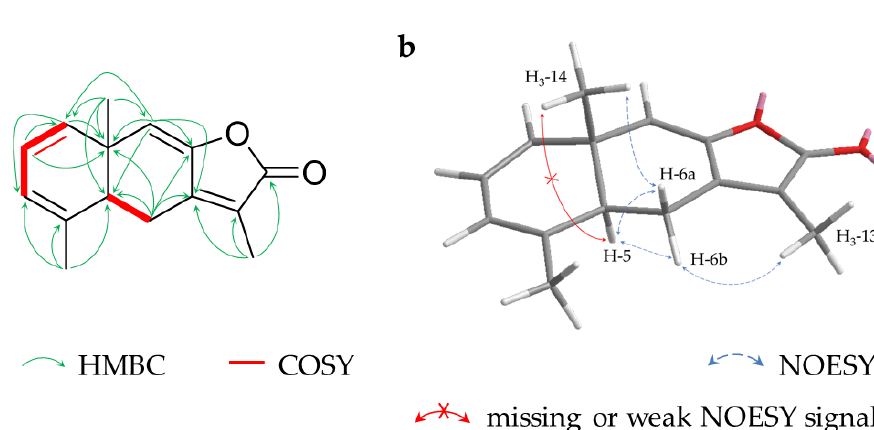
Figure 5. Key HMBC, COSY ( a ) and (missing) NOESY ( b ) correlations for compound 7 . Analysis of 2D NMR data revealed a dimer composed of a guaiane and a germacrene- type sesquiterpene, connected by a four-membered spirocycle (Figure 6a). More precisely, the spectra revealed a structure resembling commiphorine A [21]. The guaiane moiety (part I) is the C-1 epimer of the known monomer guaiane myrrhterpenoid O ( 22 ) [15] and is, thus, the same as described for the dimers commiphorine A and commiphoratone B [22]. Part (II) varies from commiphorine A. First, the double bond between C-1 (cid:48) and C-2 (cid:48) is E -configurated, deduced from NOESY signals as well as the large coupling constant of (cid:48) . Third, 3 J H-1’, H-2’ = 16.0 Hz. Second, an additional methoxy substituent is located at C-3 according to the NOESY signals, the stereochemistry at the spiro-C-10 (cid:48) is reversed, resulting in contrary axial chirality. The germacrene moiety (part II) was also isolated as a monomer ( 14 ), which is already known for C. myrrha as 3 S -methoxy-4 R -furanogermacra-1 E ,10(14)- dien-6-one [43,44]. Key HMBC signals between H-9 to C-1 (cid:48) /C-10 (cid:48) and H-9b’ to C-9 indicate a connection between the two sesquiterpene monomers (Figure